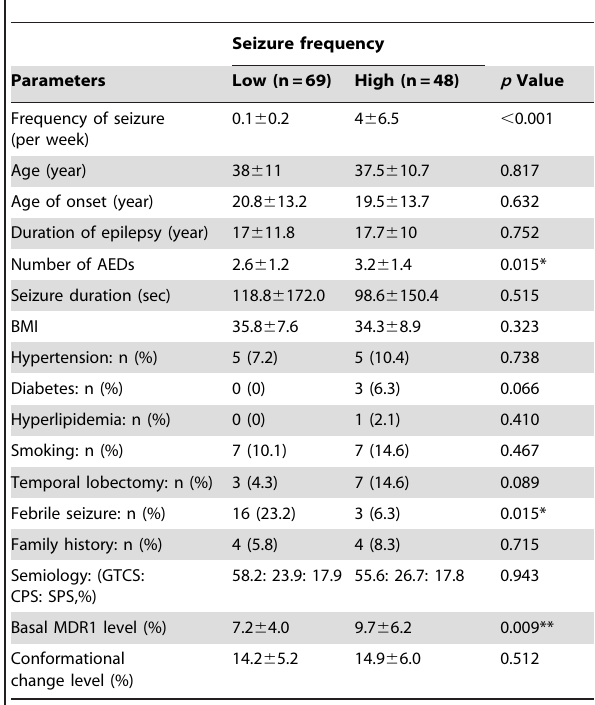
Figure 2. MDR1 profiles among groups and refractory epilepsy patients. Graphs represent (A) basal MDR1 level and (B) conformational change level among the groups. Graphs represent (C) basal MDR1 level between low- and high-seizure-frequency groups and (D) conformational change level between low- and high-medication-use groups in the refractory epilepsy patients. The horizontal lines represent the median level and standard error of the mean. doi:10.1371/journal.pone.0036985.g002 Table 3. Correlation between seizure frequency and clinical